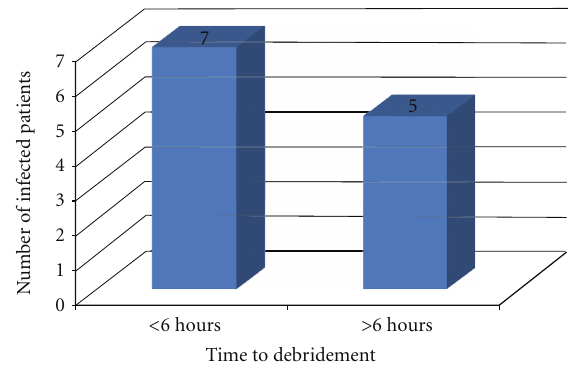
Figure 2: The infection rate amongst the two groups.